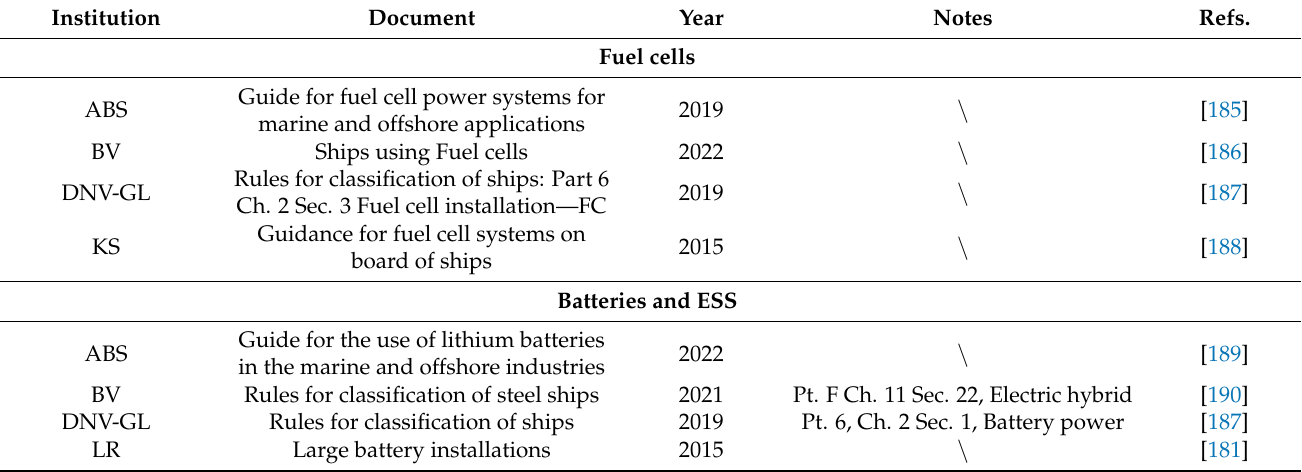
Table 7. Rules and class requirements for maritime PEMFCs and batteries or ESS installations. Information updated as of January 2022.